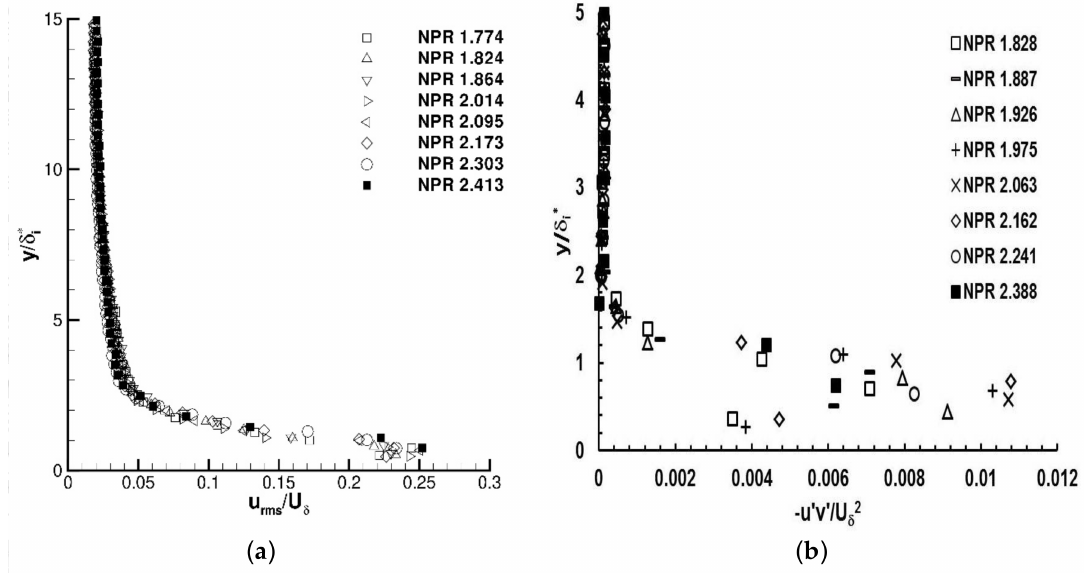
Figure 13. LU60 nozzle exit LDA measurements, NPR = 1.8–2.4. ( a ) Axial rms turbulence; ( b ) Reynolds shear